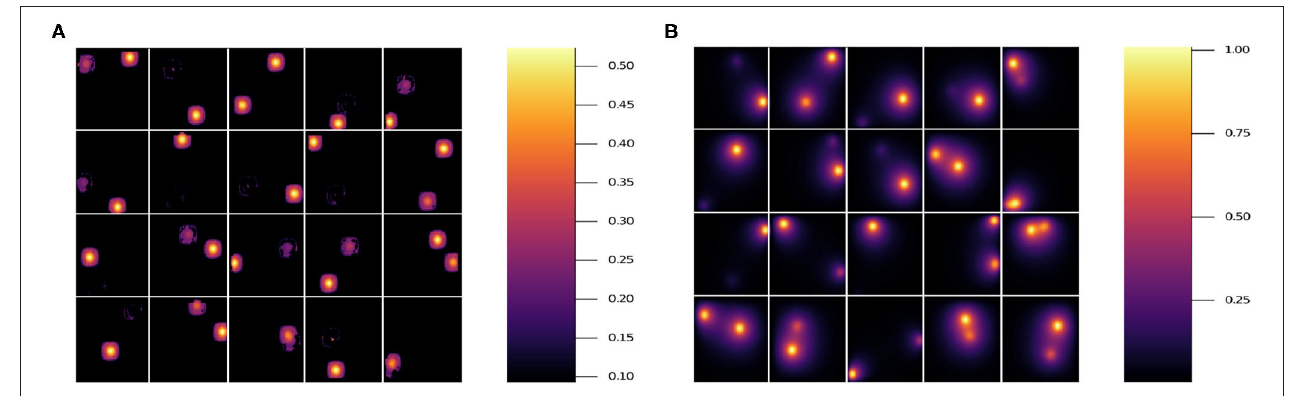
FIGURE 7 | Results for 20 randomly selected test data sets’. (A) Prediction using model 7, which only uses NN 1. (B) Prediction using model 5, which only uses NN 2 (see Table 2 ). Note the different scale on the color bars.